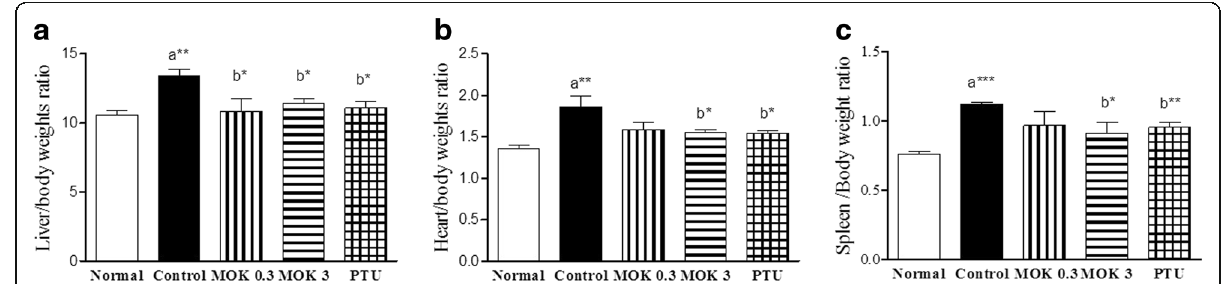
Fig. 3 Effects of MOK pharmacopuncture on the changes of organ weights in LT4-induced hyperthyroidism rats. MOK pharmacopuncture was subcutaneously administered once daily for 2 weeks, and the weights of liver ( a ), heart ( b ), and spleen ( c ) were also measured in LT4-induced hyperthyroidism rats. Relative organ weights to body weights were measured. Data are presented as mean±SD ( n =5 per each group). * P <0.05, ** P <0.01 and *** P <0.001 vs normal ( a ) or control ( b ). Normal, normal group; Control, LT4-induced hyperthyroidism group; MOK 0.3, MOK 0.3 mg/ kg-treated group in control; MOK 3, MOK 3 mg/kg-treated group in control; and PTU, PTU 10 mg/kg-treated group as a reference